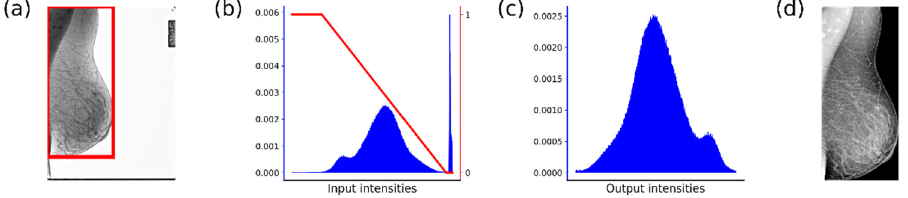
Figure 13. ( a ) An MG image in original size with an indicated region of interest, ( b ) a histogram of the original image (in blue) and intensity transformation applied for image enhancement (in red), ( c ) a histogram after pre-processing, and ( d ) a preprocessed image.